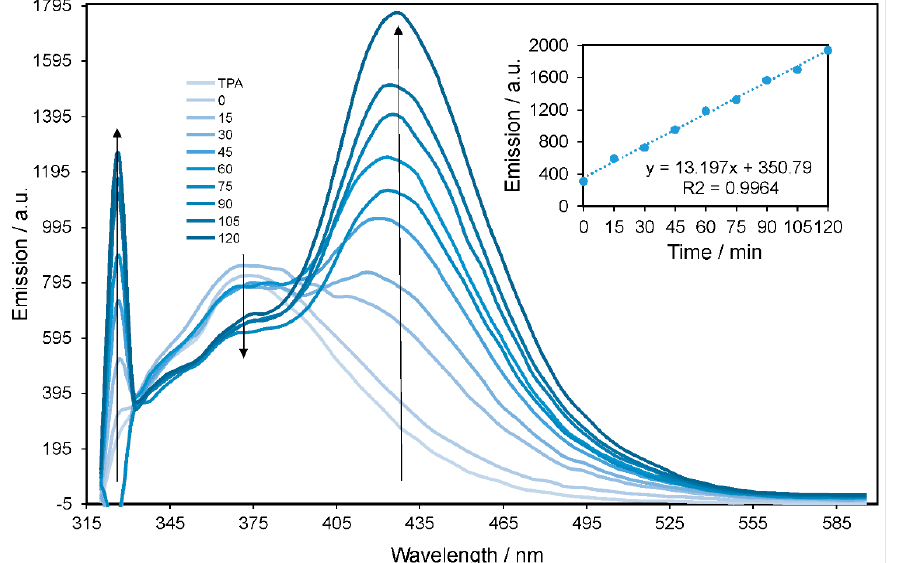
Figure 10. Fluorescence spectra of the solution of terephthalic acid (TPA) under simulated solar light irradiation in the presence of the NiAl 2 O 4 /GQDs catalyst within 2 h. Inset: time dependence of the fluorescence intensity at 426 nm.